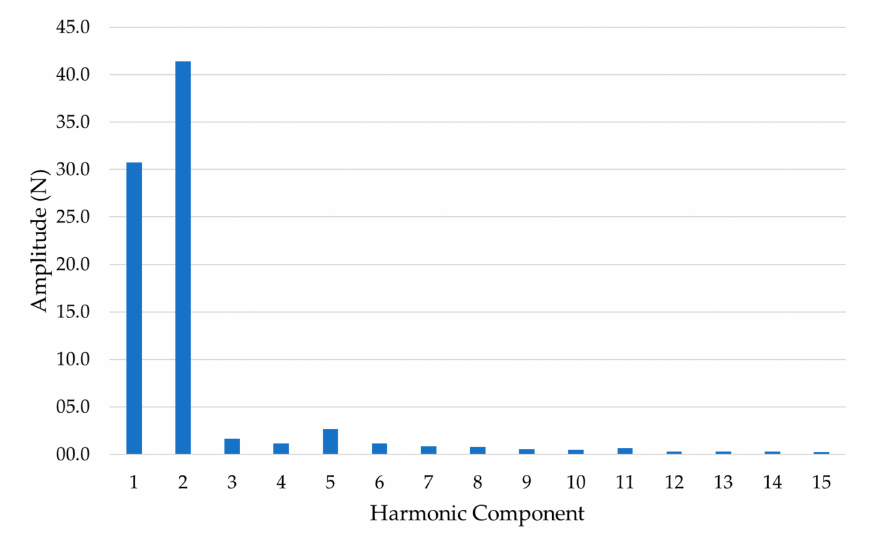
Figure 12. The Fast Fourier Transform’s decomposition of a permanent magnet’s axial forces. The frequency range set for the frequency response analysis goes from 0 to 4000 Hz and the chosen outputs are: the displacement, the velocity and the acceleration of each system’s point. Therefore, the results have been analyzed only for several characteristic points, but just the main ones are addressed in this paper: one point at the center of one stator tooth facing the air gap and another one at the radially outer point on the upper rotor’s disc. It can be stated that some harmonic components of the magnetic forces match the structure’s natural frequencies, leading to resonance phenomena in correspondence of two resonance frequencies: 600 Hz and 1531